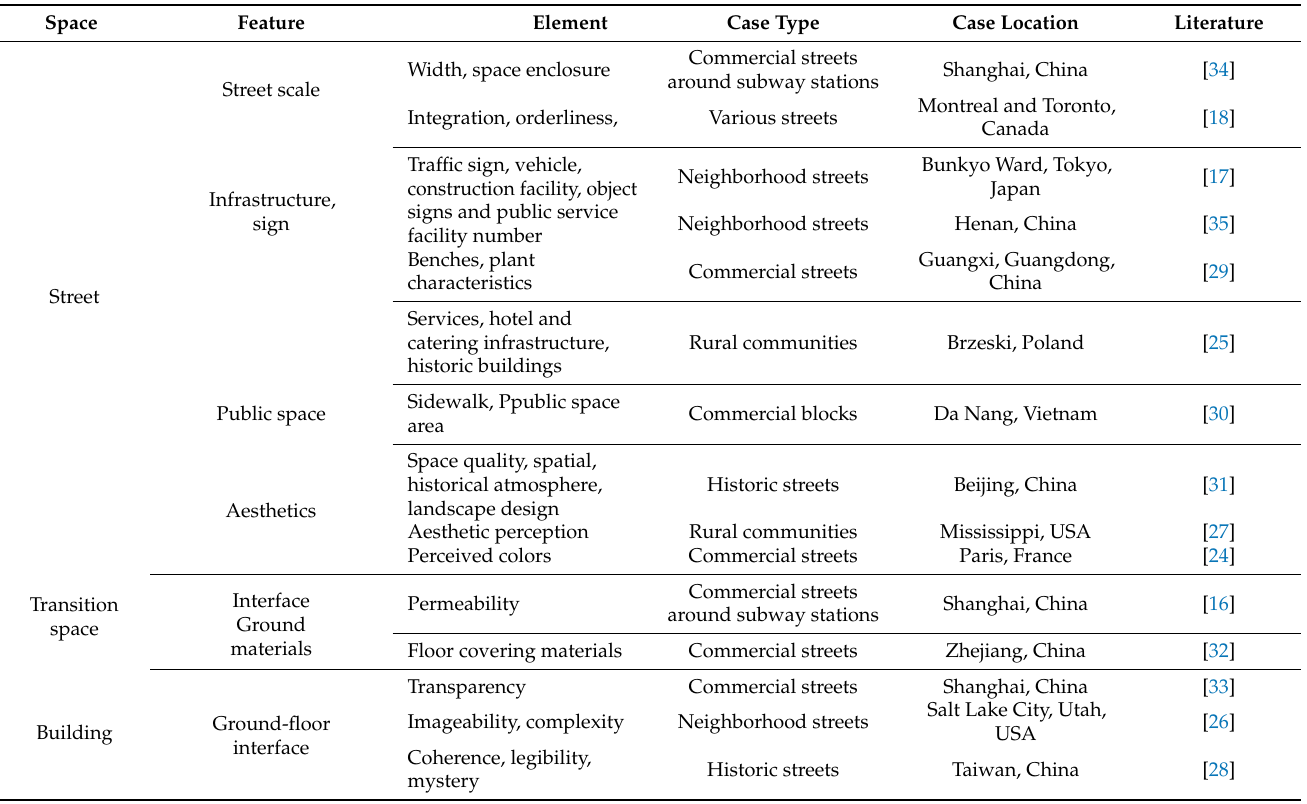
Table 1. Micro-scale elements in the existing